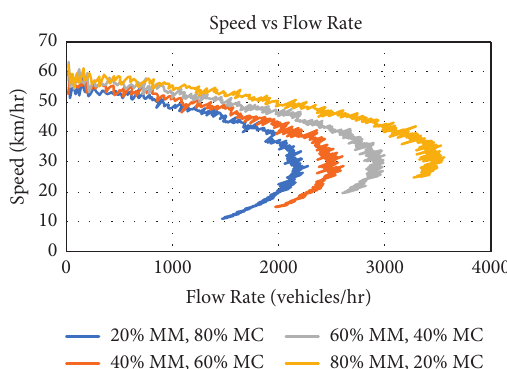
Figure 36: Speed vs. flow rate fundamental diagrams for different compositions of MM and